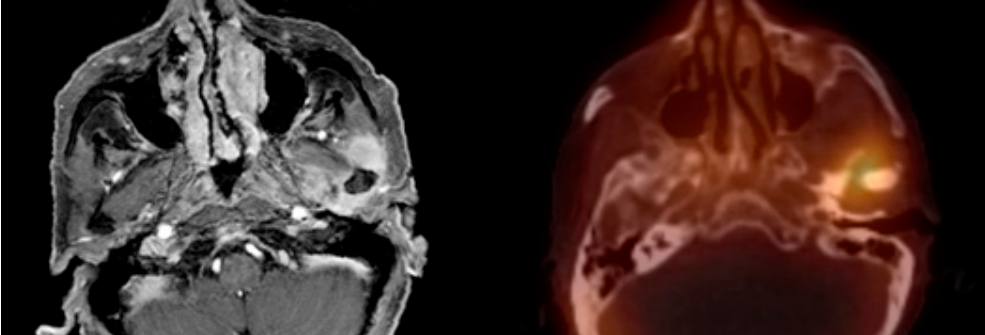
Figure 2. Imaging examination presenting the lesion (MRI on the left and scintigraphy on the right). Chronic arthritis and inflammation of surrounding tissue (33 × 18 × 22 mm). Lateral pterygoid muscle, temporalis muscle and masseter were involved.